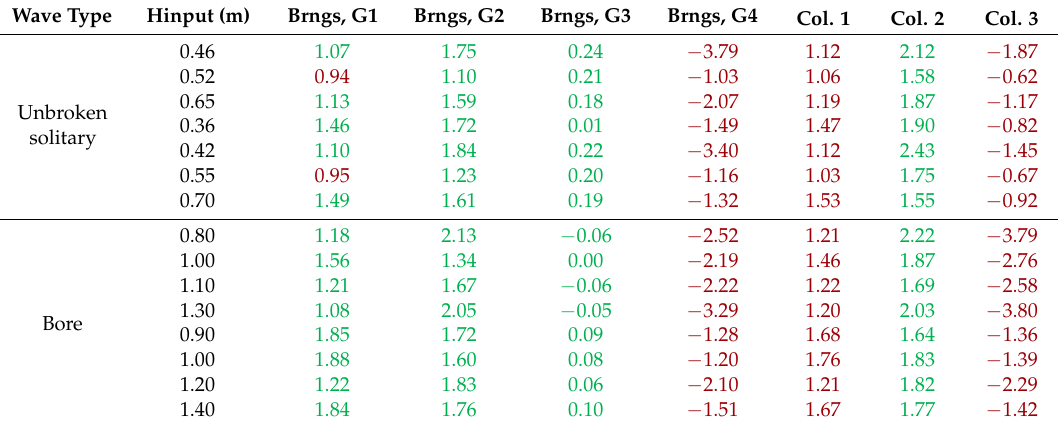
Table 5. Ratios of bearing and column-bent cap connection uplift forces calculated from load case 1 of the improved method to the respective values recorded in the experiments.